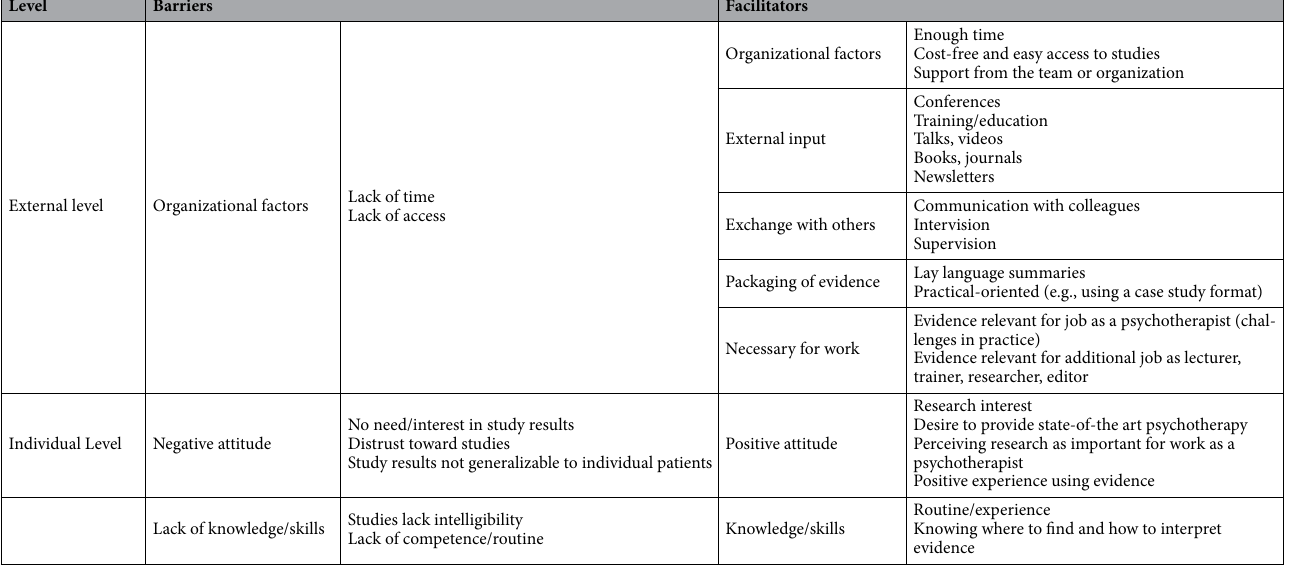
Table 5. Barriers and facilitators for implementing EBP. Abbreviations: EBP = evidence-based